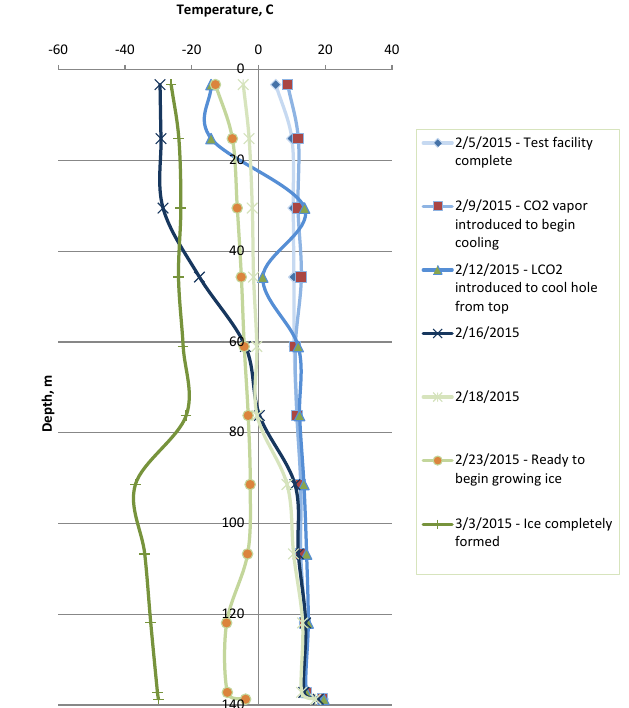
Figure 3. Temperature with depth showing the cooling history of the North American Test